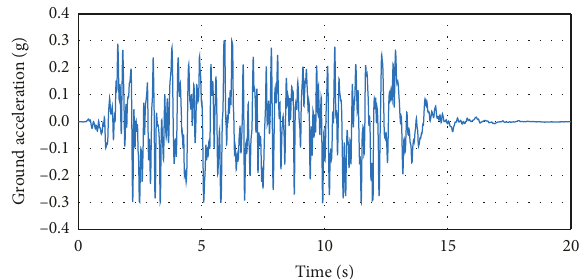
Figure 2: Artificially generated ground acceleration time history for design basis